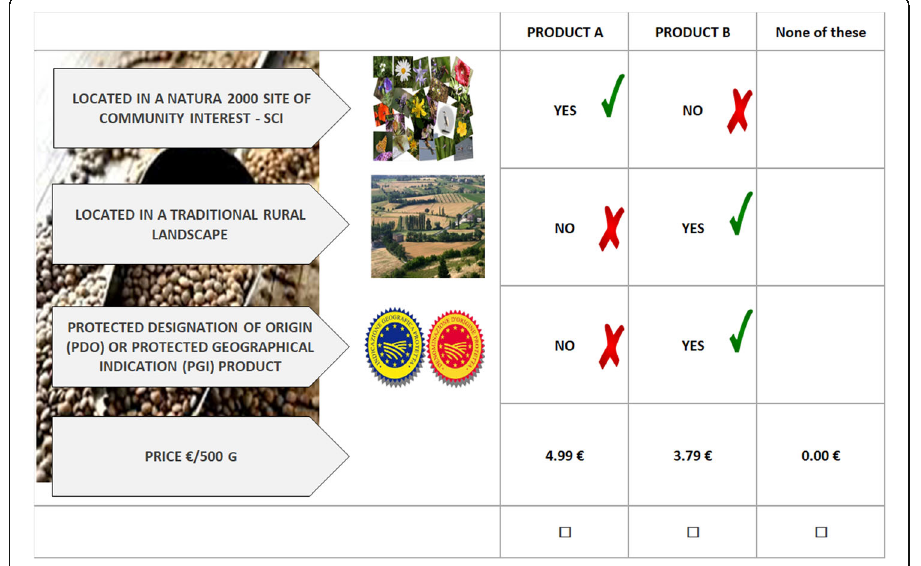
Fig. 1 Choice card example — organic